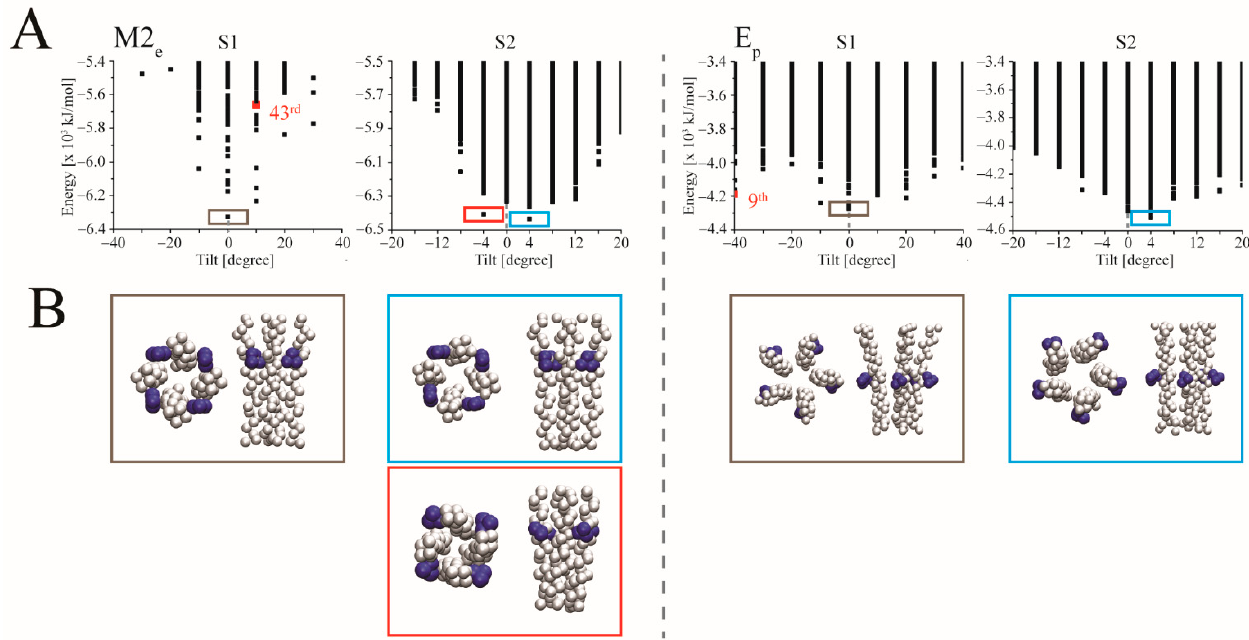
Figure 2. Ranking of coarse-grained (CG) models of tetrameric M2 e and pentameric E p plotted over tilt. ( A ) The estimated binding energies (EBEs) of M2 e and E p with a minimum value for zero tilt applying S1 protocol (grey box, left side plots for M2 e and E p ) and the subsequent S2 protocol screening around zero tilt (respective right-side plots). Red and blue boxes mark minimum energies for structures with tilts lower and larger, respectively, than tilt values with zero tilt. Energies for structures with the proper orientation of the marker residues are marked as red spheres with the ranking (e.g., 9 th ) outlined. ( B ) Structural models with the lowest energies in the S1 protocol (grey box) and S2 protocol (red and blue boxes). The marker residues H37 and F26 for M2 e and E p , respectively, are shown in dark blue spheres.